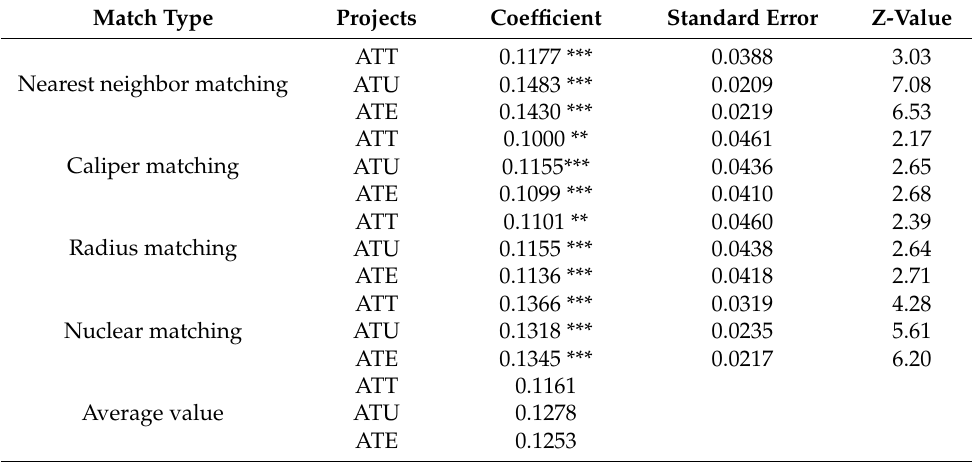
Table 8. The PSM matching results.